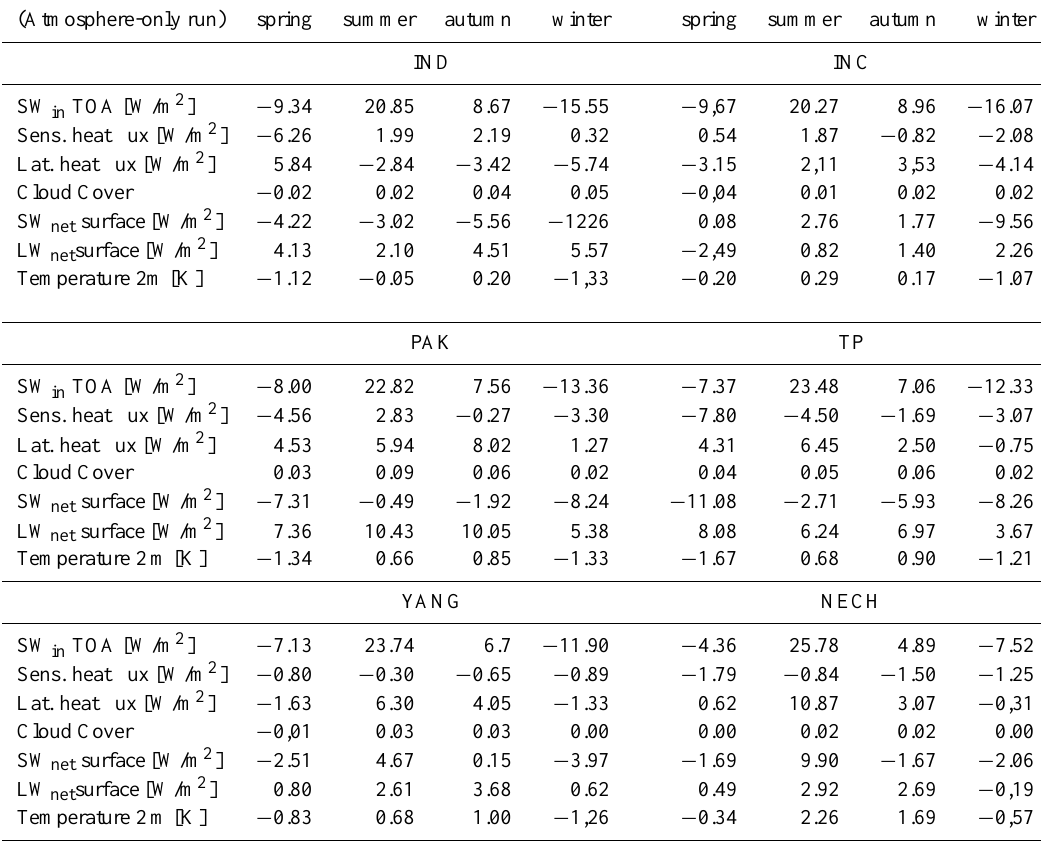
Table 3. Differences between mid-Holocene and present-day climate for certain parameters characterising the energy balance of the surface. Differences are calculated for each sub-region, based on results of the atmosphere-only run. Listed are incoming shortwave radiation at the top of the atmosphere (SW in TOA), sensible and latent heat flux (positive values indicate a higher flux from the surface to the atmosphere in 6k compared to 0k), total cloud cover, net shortwave radiation at the surface (SW net surface [W/m 2 ]), net longwave radiation at the surface (LW net surface [W/m 2 ]), and near-surface temperature.